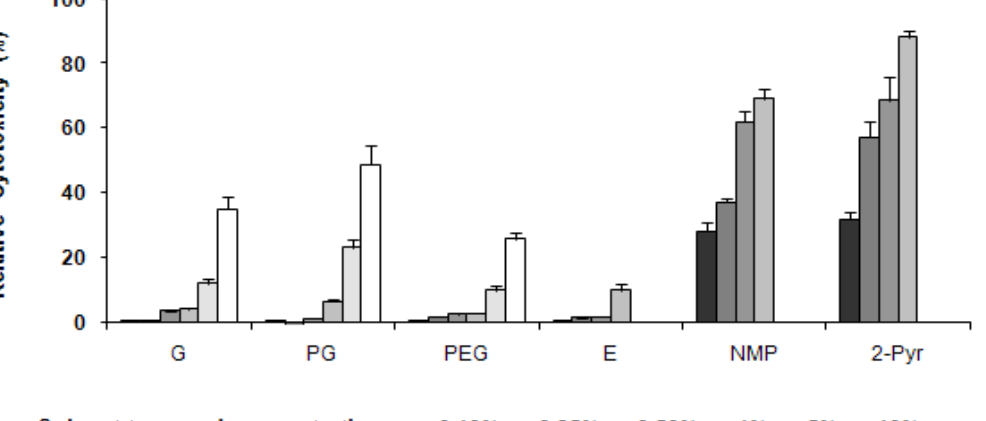
Figure 7. Cytotoxicity of co-solvents on MAC-T cells after 72 h incubation as detected by the LDH assay ((mean ± SD, n = 3). Black, various shades of grey and white bars depict the concentrations of each solvent system ranging from 0.1, 0.25, 0.5, 1, 5 and 10%. The standard deviation is shown by the error bars.